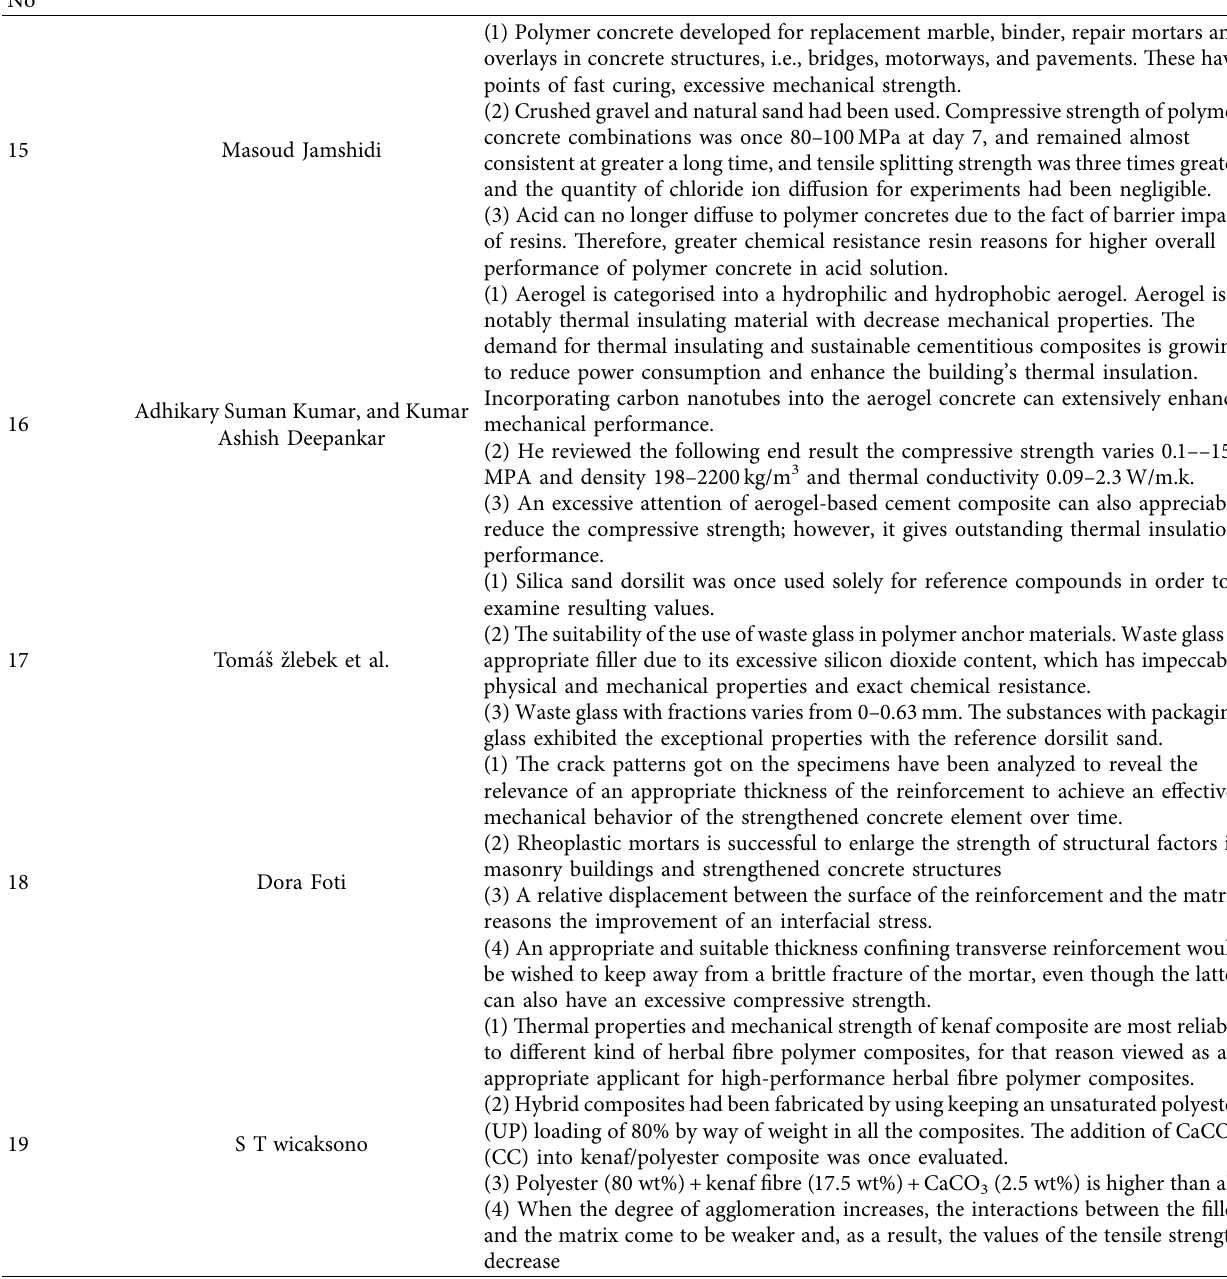
Table 3: Summary of previous work related to polymer-based lightweight